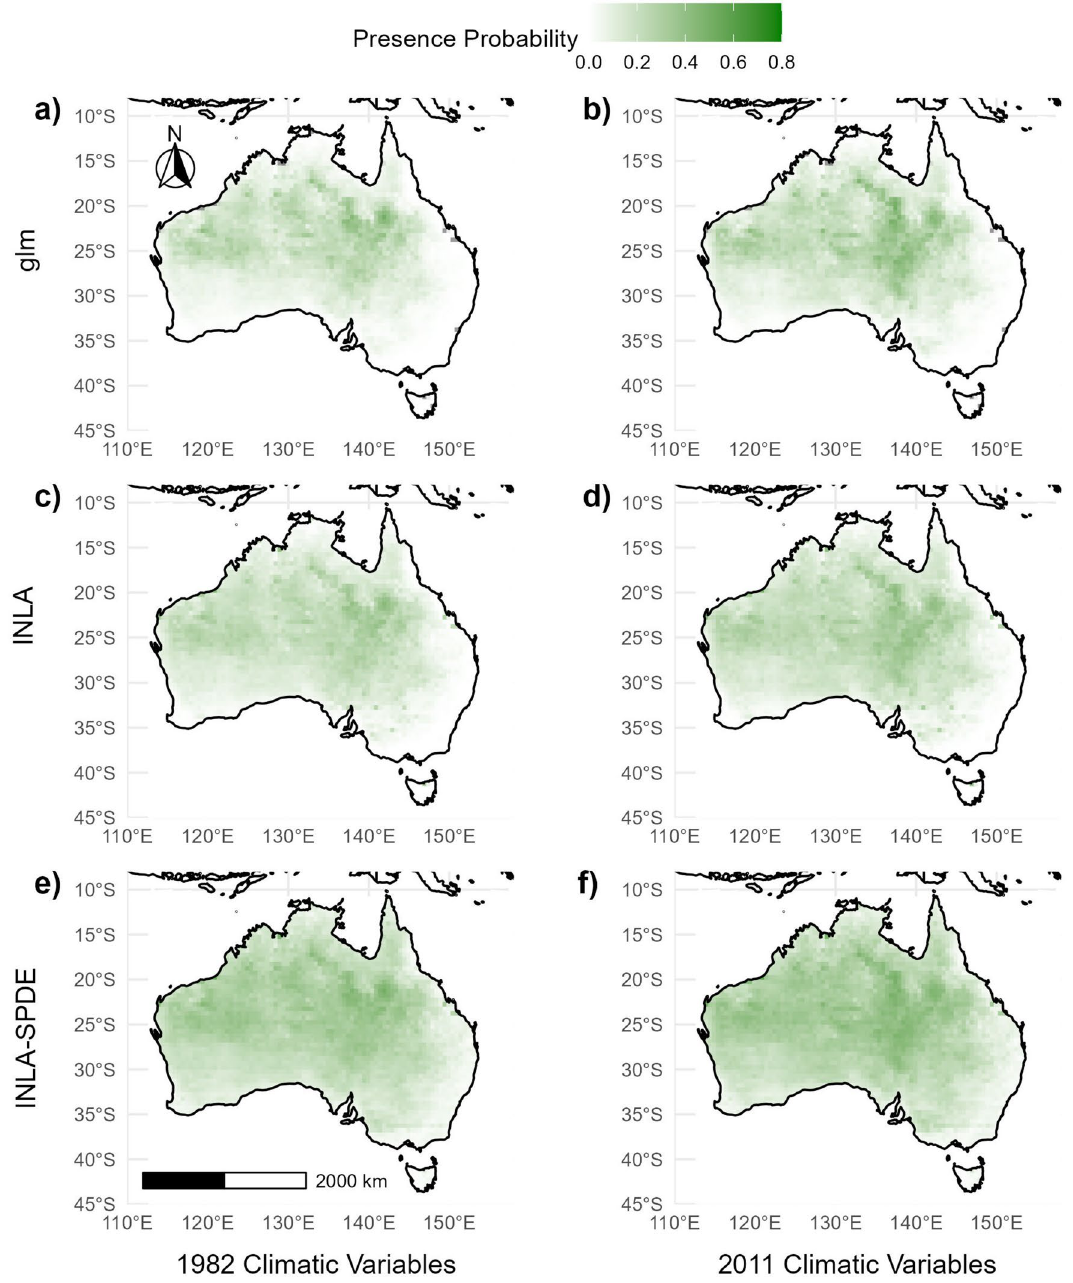
Figure 3. Probabilistic spatial extrapolation plots of ( a ) A. pectinata species presence modelled using climatic data from 1982 using glm, ( b ) A. pectinata species presence modelled using climatic data from 2011 using glm, ( c ) A. pectinata species presence modelled using climatic data from 1982 using INLA, ( d ) A. pectinata species presence modelled using climatic data from 2011 using INLA, ( e ) A. pectinata species presence modelled using climatic data from 1982 using INLA-SPDE and ( f ) A. pectinata species presence modelled using climatic data from 2011 using INLA-SPDE. For spatial extrapolation plots of B. ewartiana , D. fecundum , and T. triandra , refer to Supplementary Figures 3, 4 and